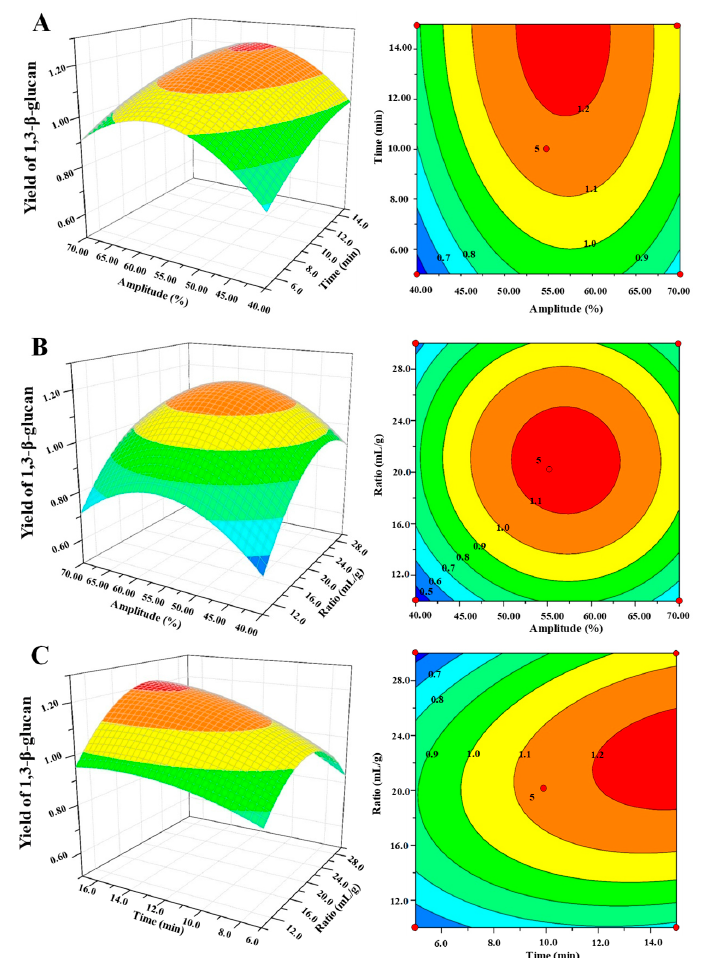
Figure 4. Three-dimensional response surface (left) and two-dimensional contour (right) plots showing the interaction effects on the extraction yield of water soluble 1,3- β -glucans: ( A )